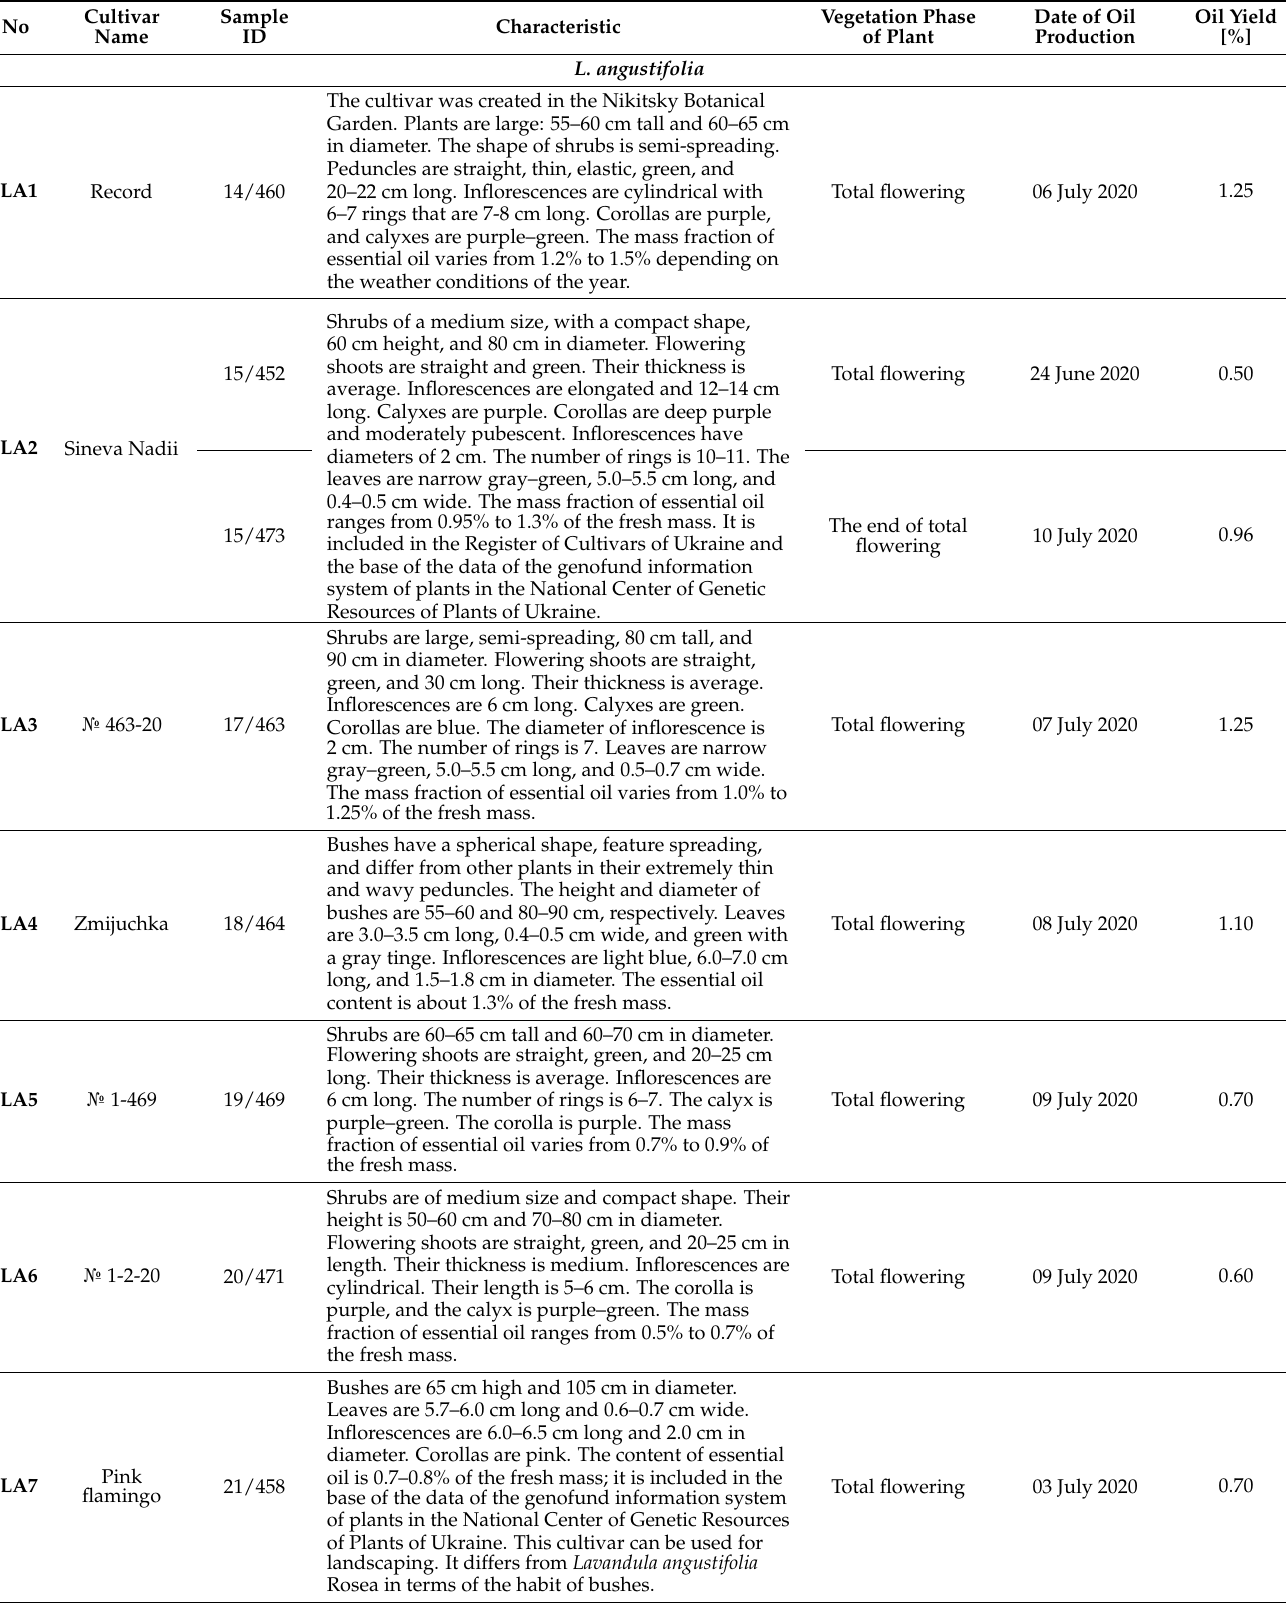
Table 8. Information about the studied cultivars of L. angustifolia and L. x intermedia